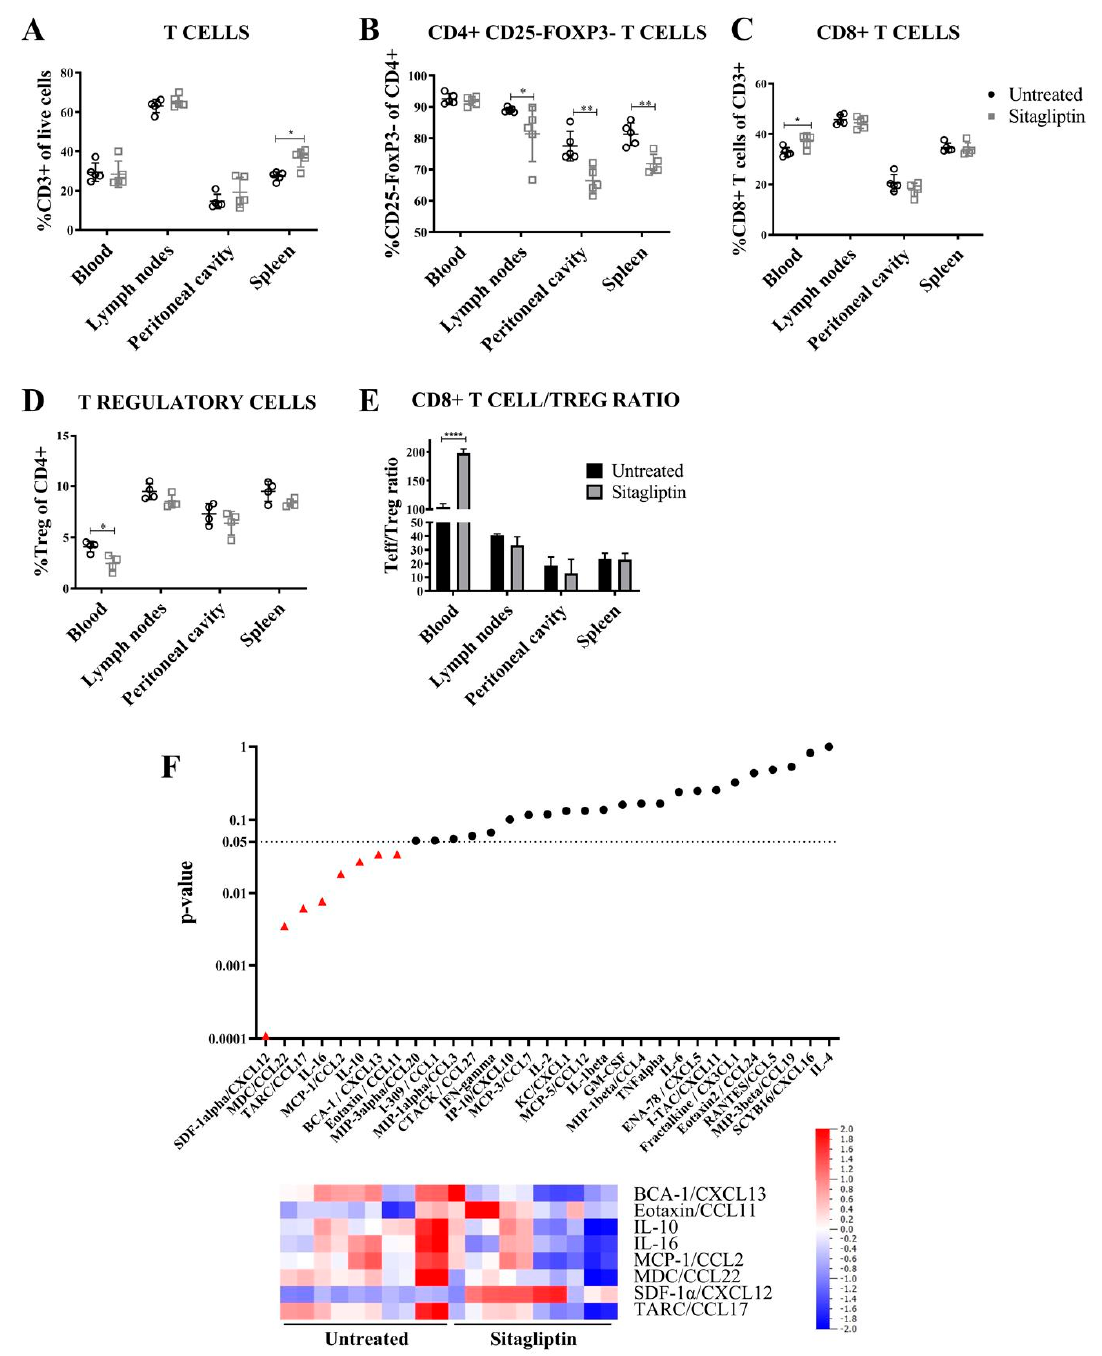
Figure 3. Gross lymphocyte populations and circulating cytokines in mice treated with sitagliptin. Leukocytes were isolated from the blood, lymph nodes, peritoneal cavity and spleen of ID8 pROSA -iRFP720-bearing mice at week four post-inoculation and examined using a BD LSRFortessa X-20 (BD Biosciences). ( A ) Percentage of CD3+ T cells of live cells. ( B ) Percentage of CD4+ T cells (CD3+CD4+CD25-FoxP3-) of CD4+ cells. ( C ) Percentage of CD8+ T cells (CD3+CD8+) of CD3+ cells. ( D ) Percentage of T regulatory cells (CD3+CD4+CD25+FoxP3+) of CD4+ cells. ( E ) CD8+ T cell/T regulatory cell ratio. Data are presented as mean ± SD, n = 5. * = p < 0.05; ** = p < 0.01; **** = p < 0.0001. ( F ) Cytokines significantly altered in the serum of mice receiving sitagliptin examined at week four post tumour inoculation. The heat map represents cytokines with significant changes between the untreated and sitagliptin-treated mice (individual mice shown). Blue indicates the lowest value while red indicates the highest value. Data analysed using Qlucore Omics Explorer v3.5 (Qlucore AB, Lund,